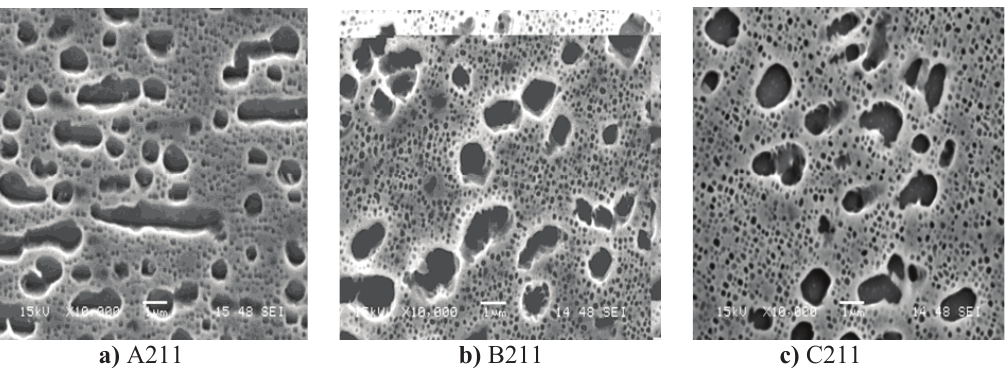
Figure 26. Microstructures of specimens after reheat treatment of Program